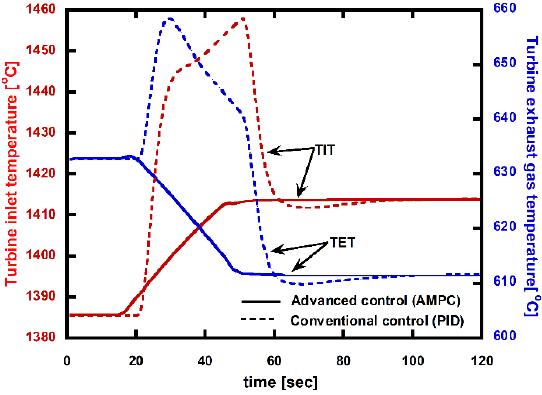
Figure 20. Simulated variations in gas turbine power and rotational speed with increasing load (ramp rate: 60 MW/min).